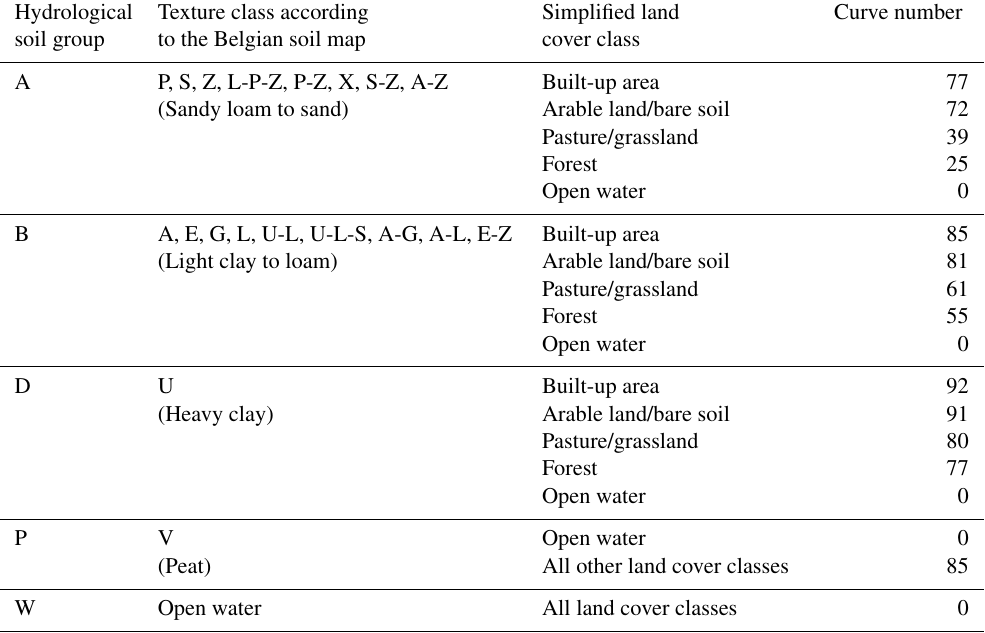
Table A3. Curve number values used for each combination of a hydrological soil group and a simplified land cover class. For each hydro- logical soil group, the corresponding texture classes according to the Belgian soil map are listed.